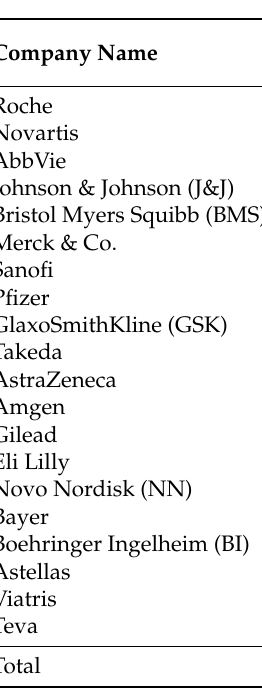
Table 1. Overview of the 20 pharmaceutical companies included in the